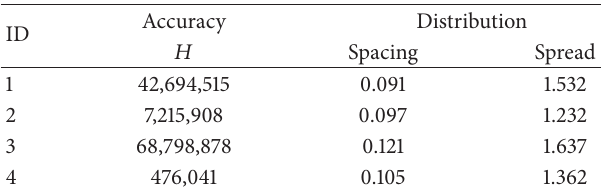
Figure 3: Scatterplot of Item 1 nondominated solutions from successive approximation. Table 6: Performance measures of the successive approximation